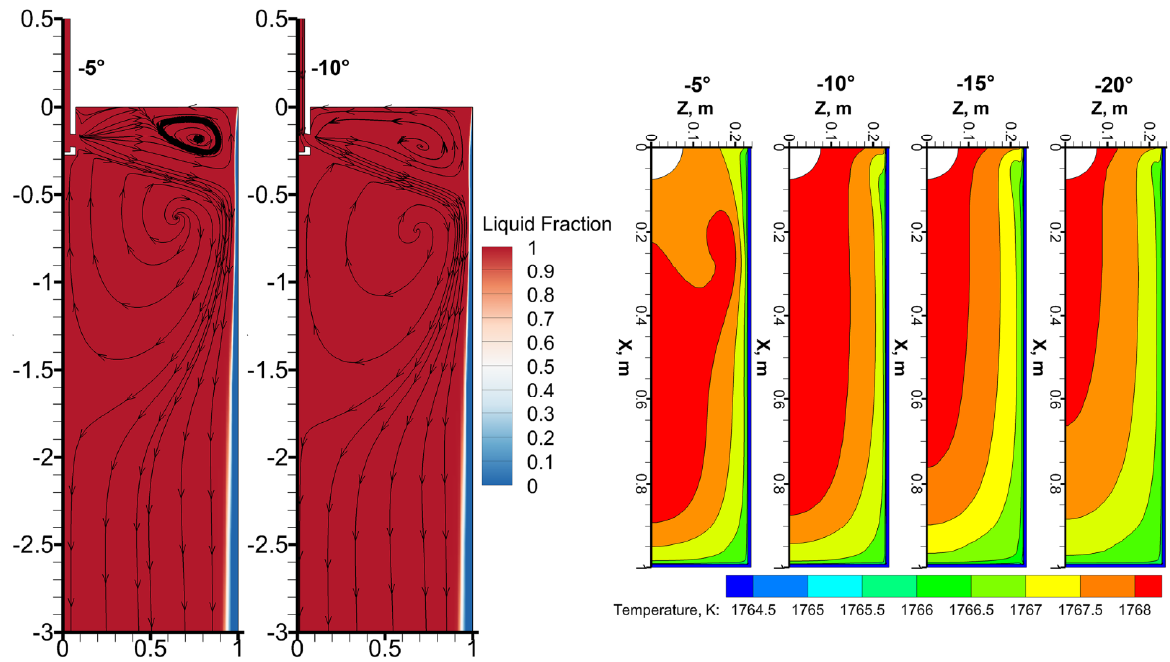
Figure 9. Effect of SEN port angle on molten steel flow in the mold and temperature distribution on the meniscus.